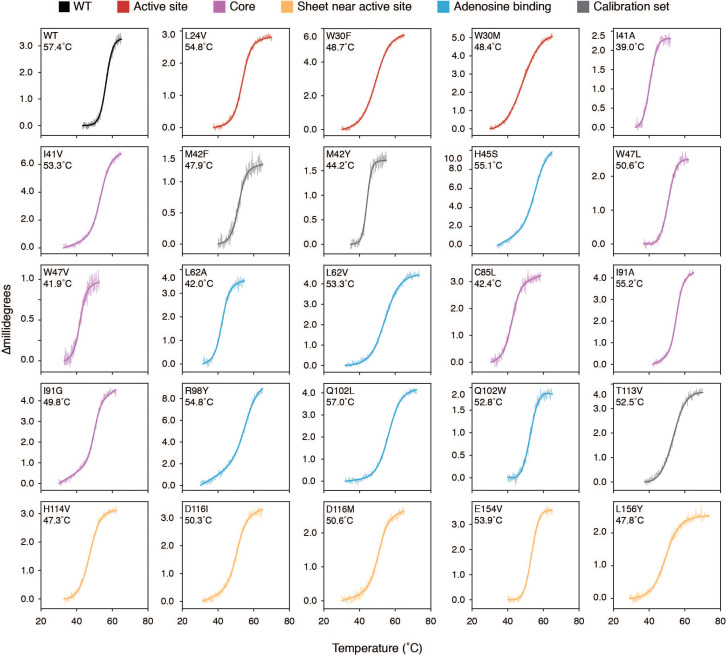
Thermal denaturation curves monitored by CD signal at 225 m for selected hotspot mutants.The curves are colored by the mutation’s location within the hot spots from Figure 4 and Figure 4—figure supplement 1. The raw data are shown with thin lines and the fitted curves are shown as thick lines. For each plot, the mutant identity and apparent Tm value are listed in the top left corner.